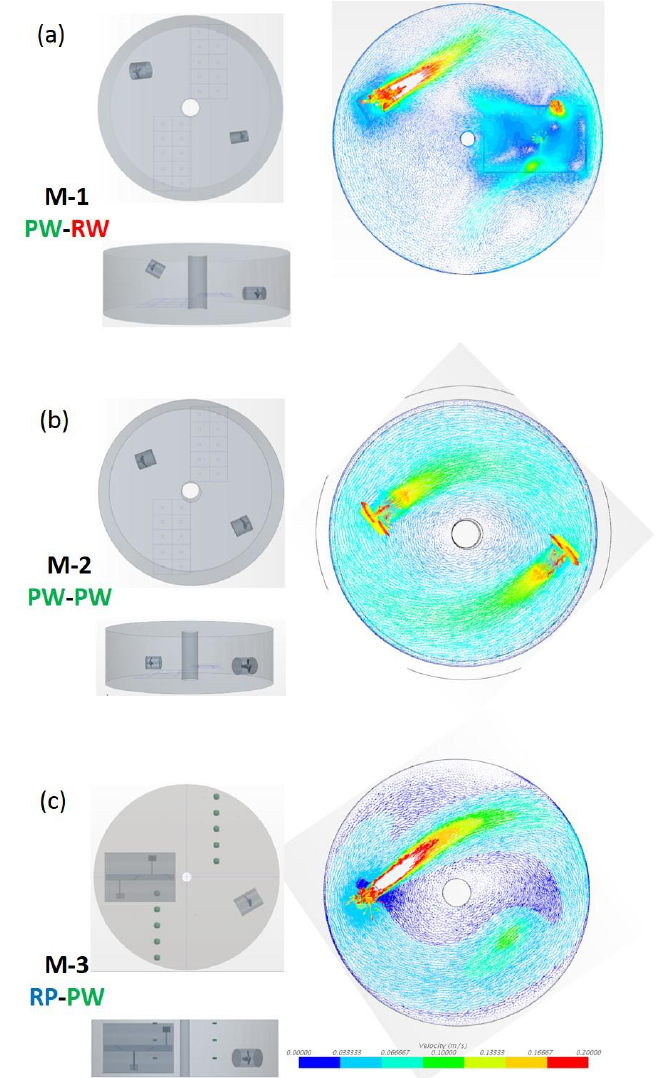
Fig. 5. Simulations results from CFD calculations: CAD models and visualization of the flow velocity in the three mixing configurations: (a) M-1, with a pointed blade propeller (PW) and a rounded blade propeller (RW); (b) M-2, with two pointed blade propellers (PW); (c) M-3 with a paddle system (RP) and a pointed blade propeller (PW)